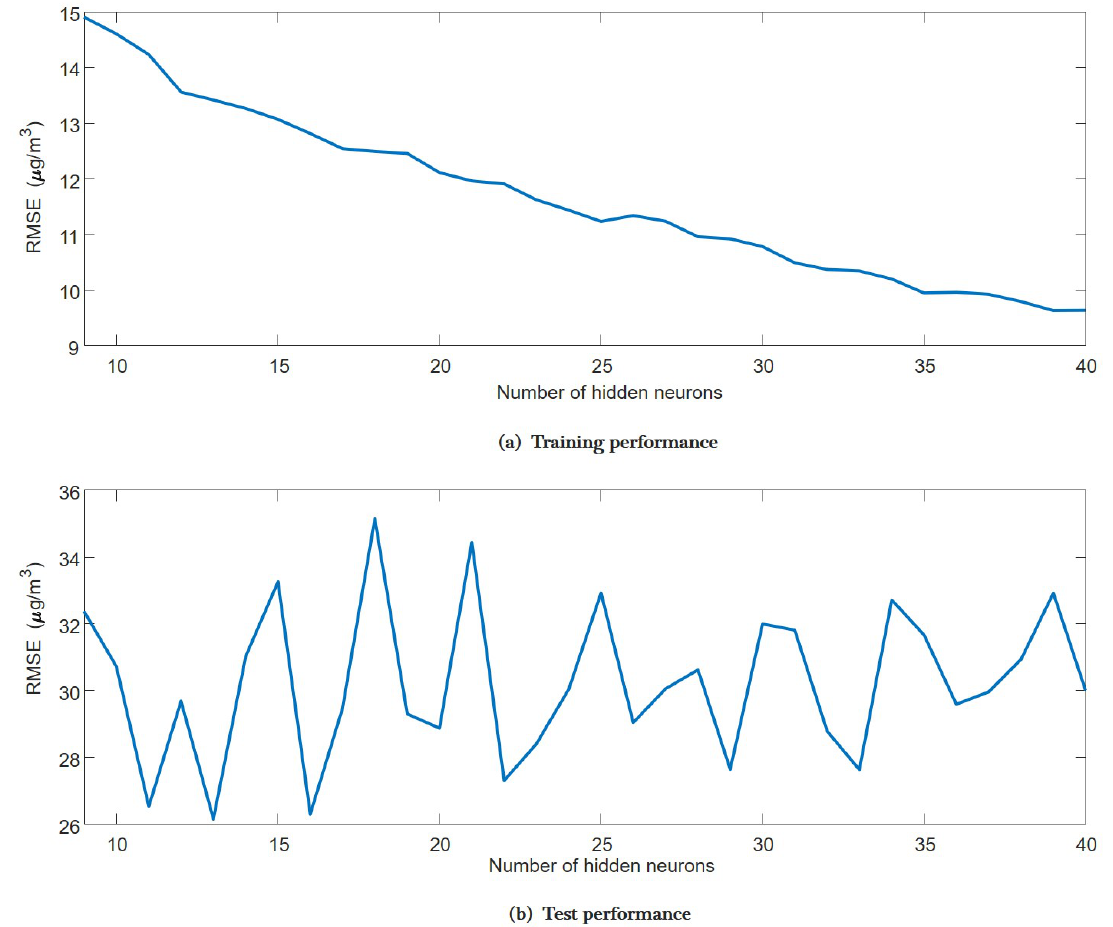
Figure 6. The figure shows variations of the training performance (a) and the test performance (b) with respect to the number of hidden